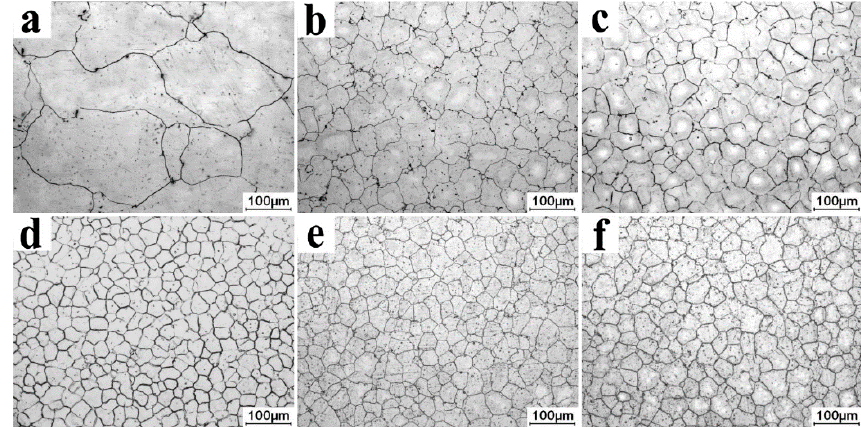
Figure 5. OM micrographs of as-solution Graphite/AZ91D composites with different Grp content: